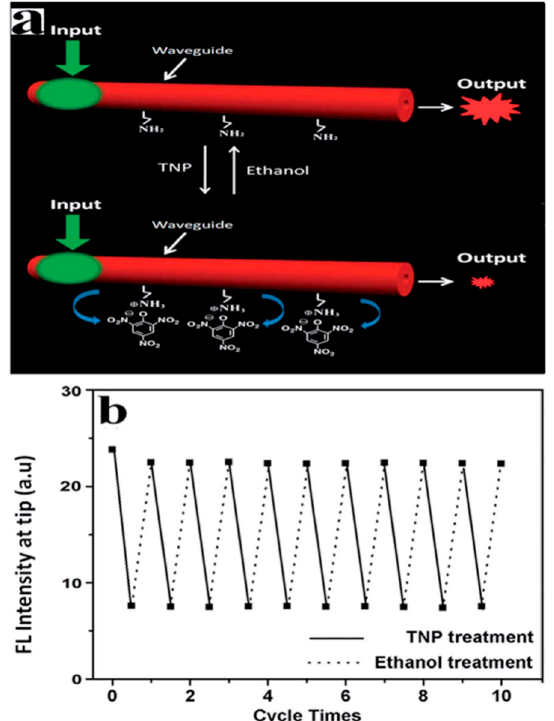
Figure 16. Detection of trinitrophenol (TNP) based on optical response of a PDA-microtube waveguide sensor. ( a ) Schematic diagram. ( b ) Changes of the outcoupled tip emission intensity (at 640 nm) of the PDA microtube waveguide sensor upon repeated TNP sensing and regeneration cycles